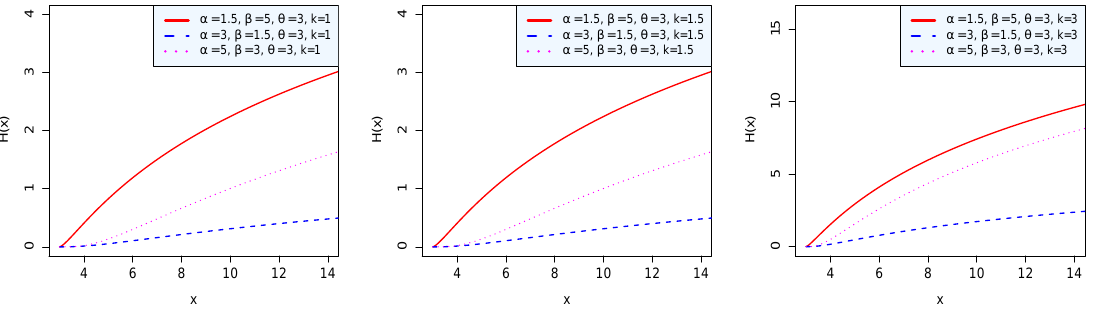
Figure 5. Cumulative hazard rate of the BP